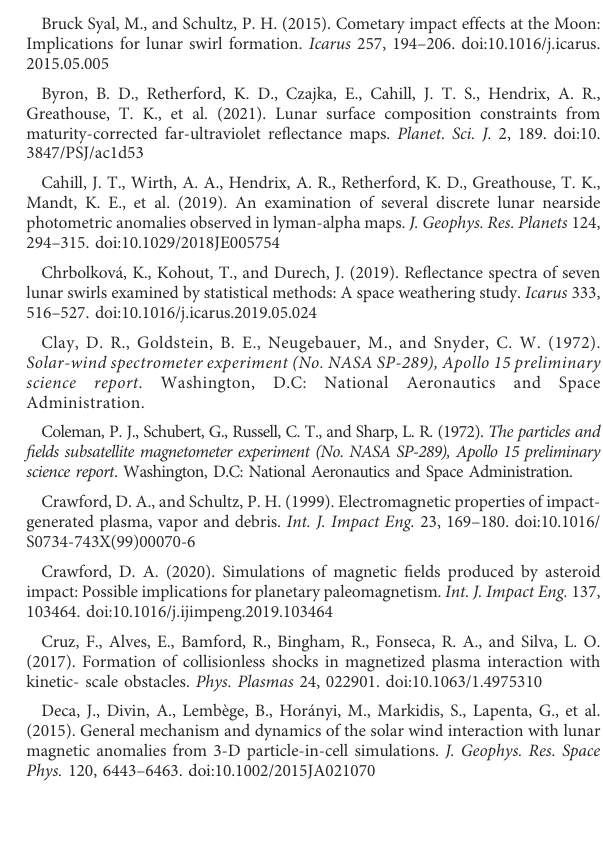
SUPPLEMENTARY FIGURE S1 A side-by-side comparison of all pro fi les in ultraviolet and magnetic perspectives. The current planned LVx landing site is indicated by a red dotted line on Pro fi le